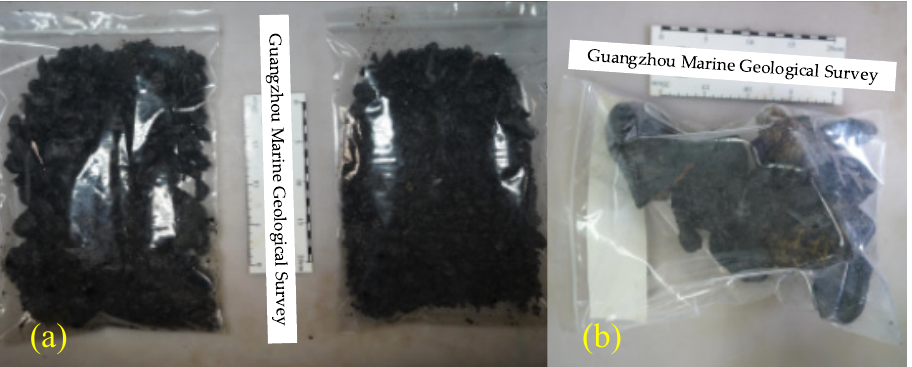
Figure 17. Particles: ( a ) small particles, ( b ) big particles.